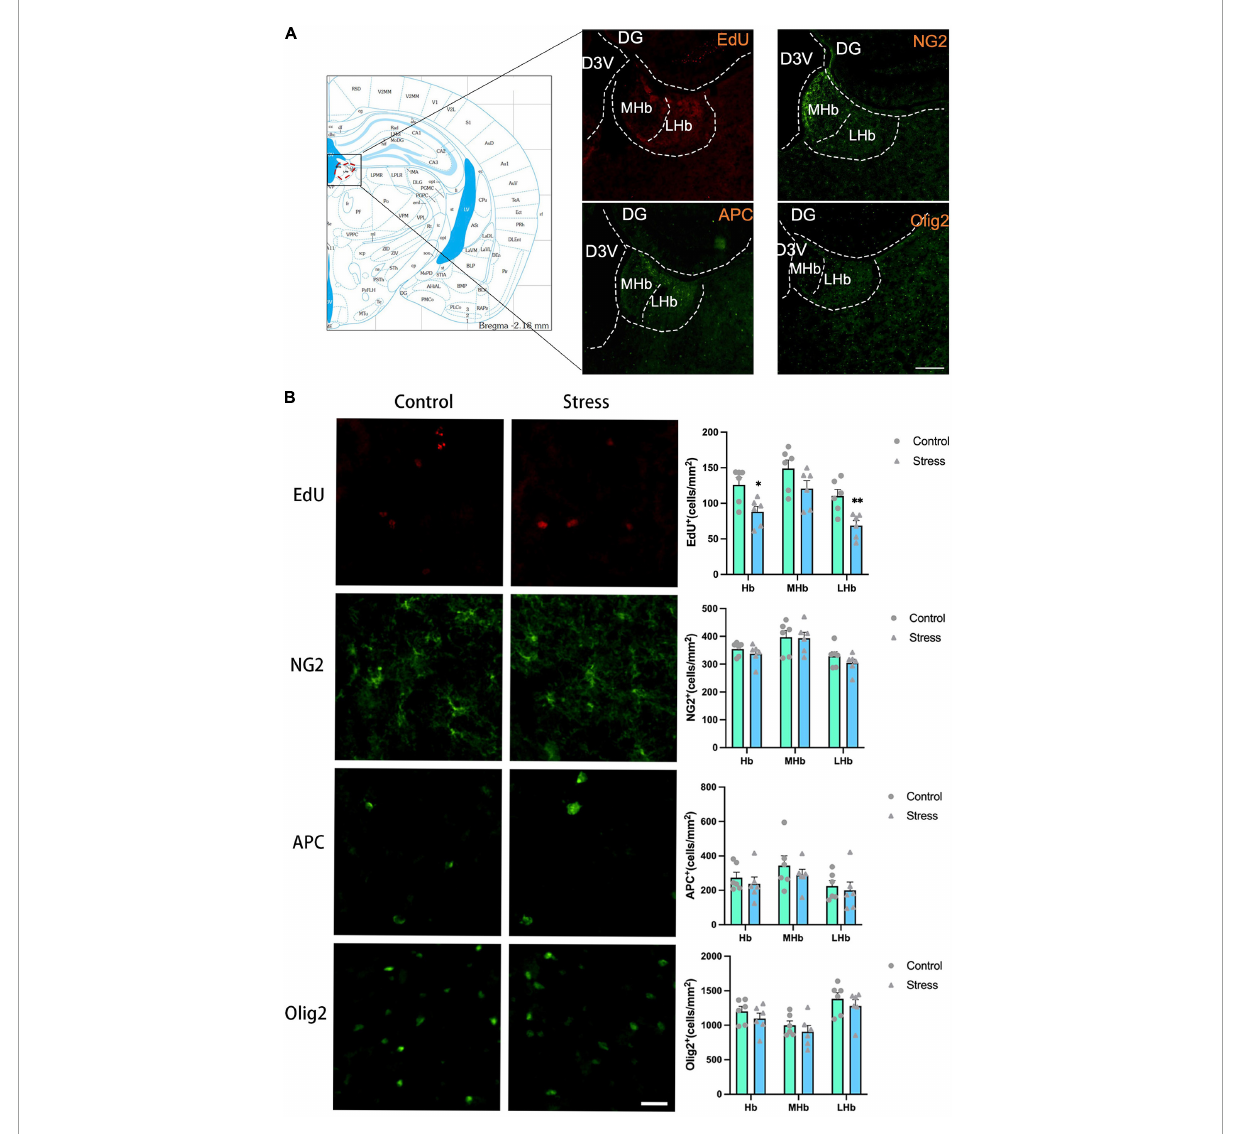
FIGURE5 The effects of chronic social defeat stress (CSDS) on the oligodendrocyte lineage cells in the lateral habenula (LHb) of adolescent mice. (A) Schemata showing the habenula (Hb) regions for immunofluorescence and the representative images of immunofluorescence staining of EdU, NG2, APC, and Olig2. Magnification: 100 × . Scale bars: 200 µ m. (B) The representative images of immunofluorescence staining of EdU, NG2, APC, and Olig2 in the Hb (left panels) and the bar graphs showing the numbers of EdU + , NG2 + , APC + , and Olig2 + cells in the total Hb area (LHb + MHb), LHb, and MHb areas (right panels). Magnification: 100 × . Scale bars: 25 µ m. Data are expressed as mean ± SEM. The number of animals used is as follow: EdU (control, n = 6; stress, n = 6); NG2 (control, n = 6; stress, n = 6); APC (control, n = 6; stress, n = 6); Olig2 (control, n = 6; stress, n = 6), ∗ P < 0.05, ∗∗ P < 0.01, Stress vs.